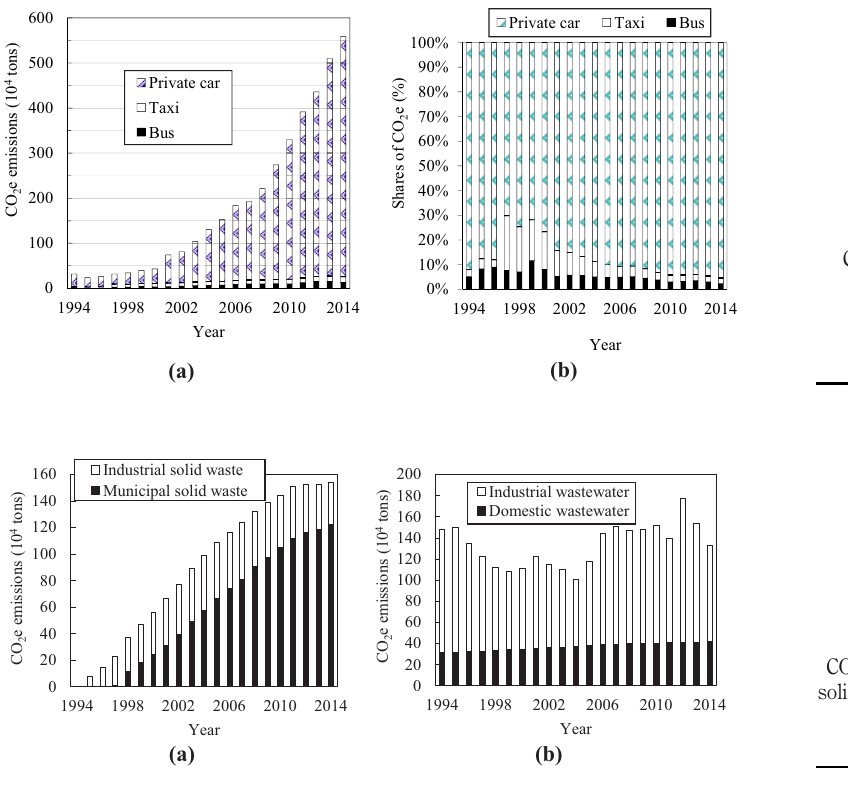
Figure 6. CO 2 e emissions from solid waste land fi ll (a)